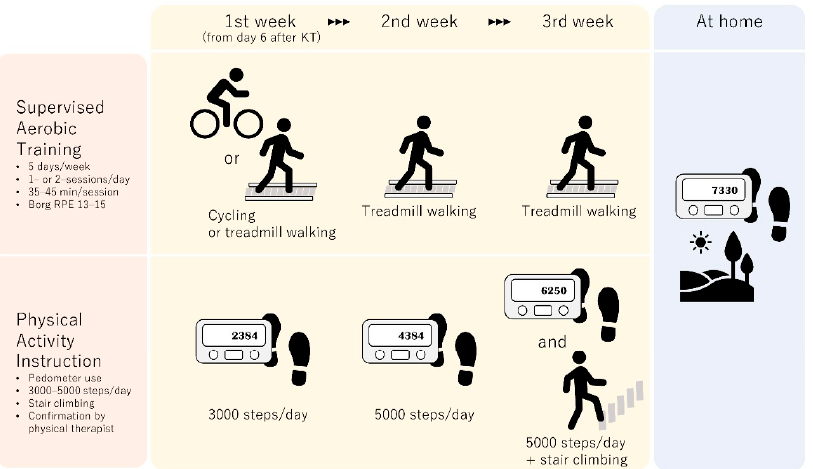
Figure 5. Protocol exercise intervention for patients after kidney transplantation, created based on a reference from Yamamoto et al. [56]. KT: kidney transplantation; RPE: rating of perceived